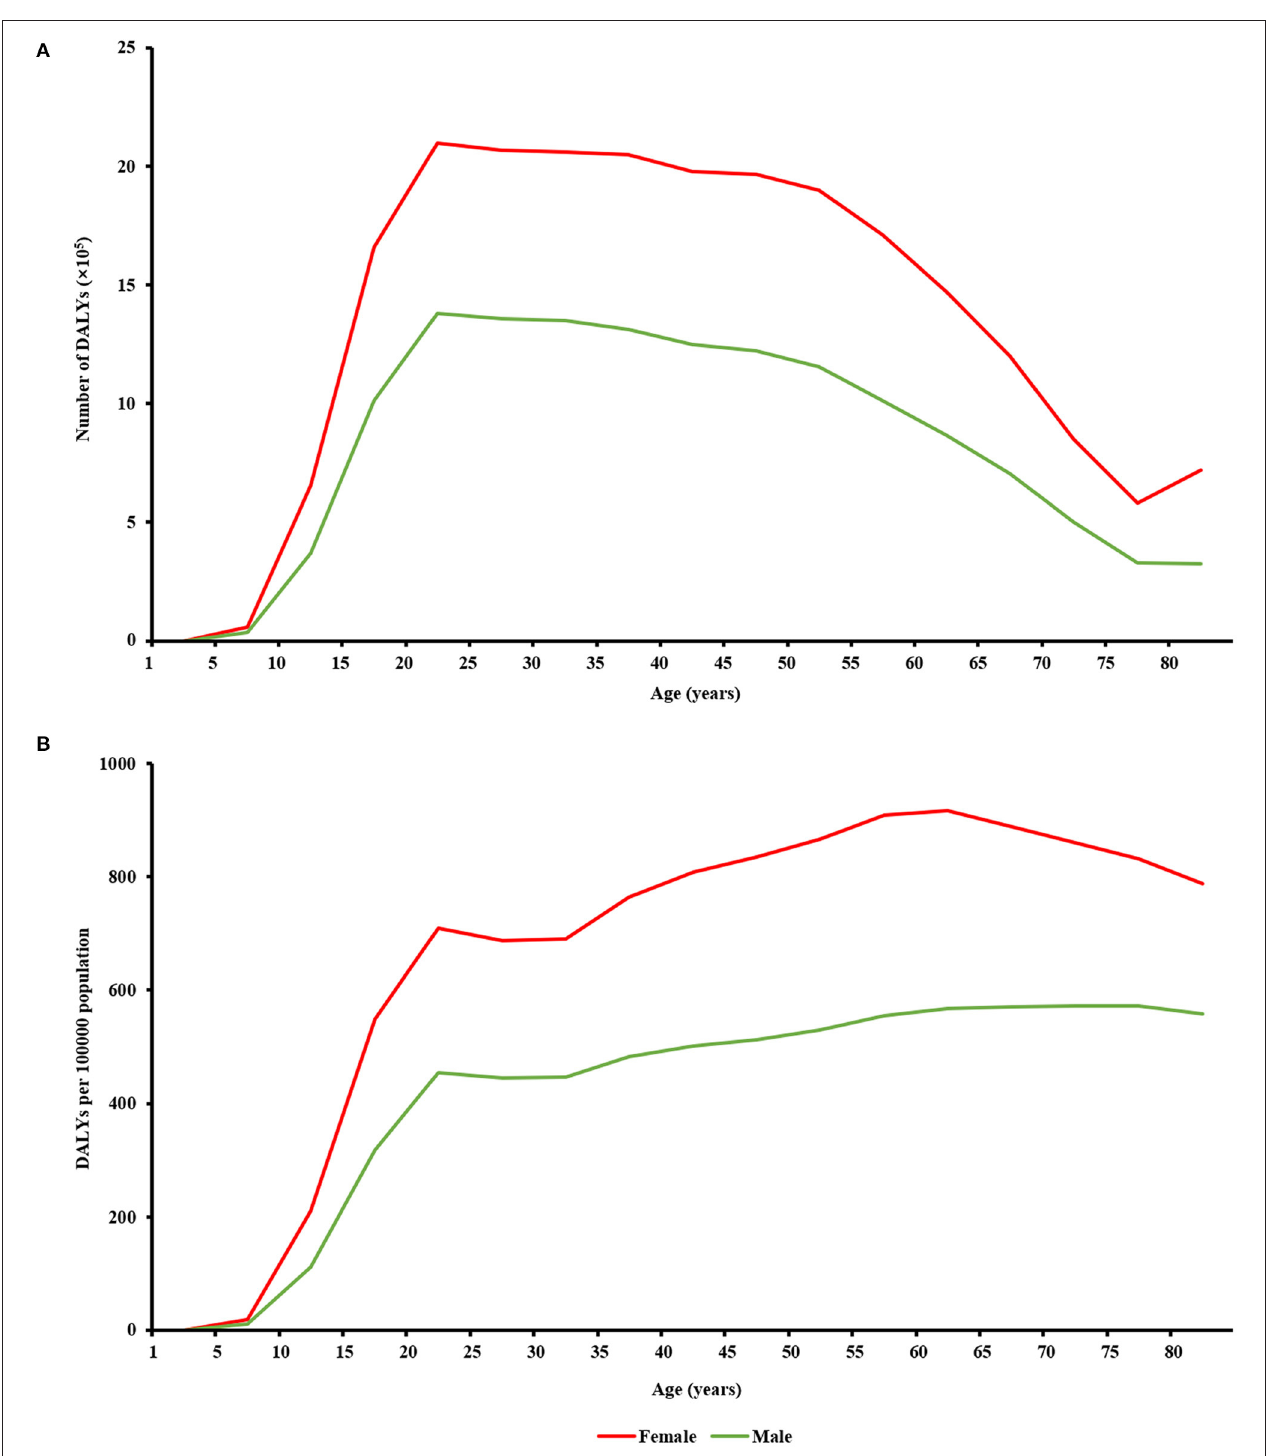
FIGURE 3 | Sex difference in global burden of major depressive disorder in different age groups in 2019, in terms of (A) DALY numbers and (B) crude DALY rates.